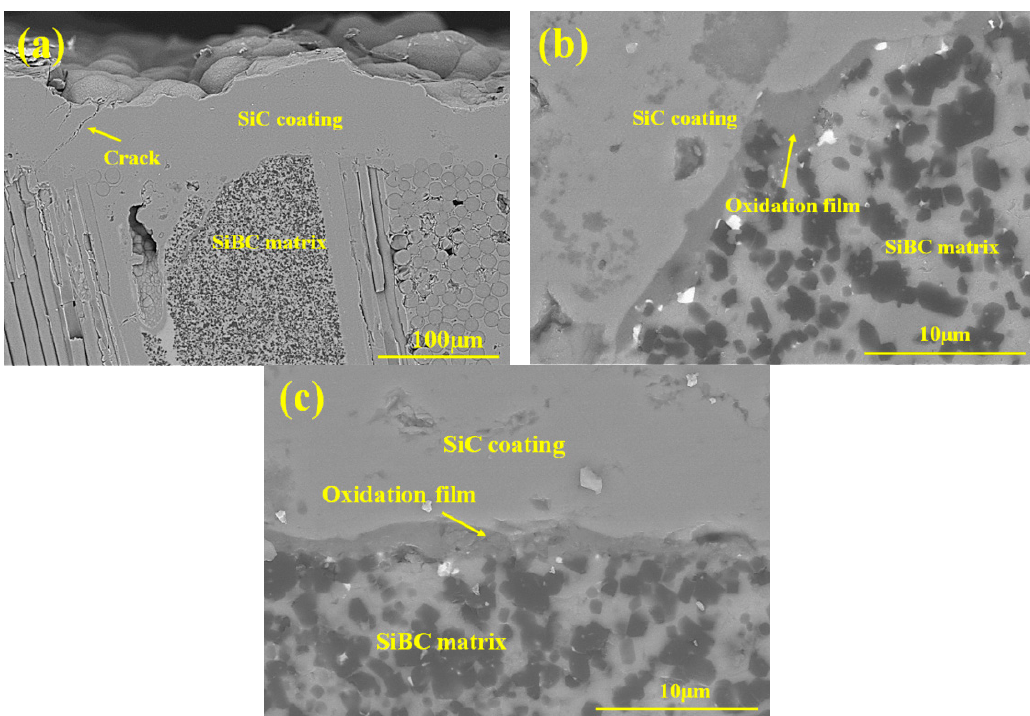
Figure 7. ( a ) Showing the coating crack of SiC/SiC-SiBC, ( b , c ) showing the dense oxidation film.